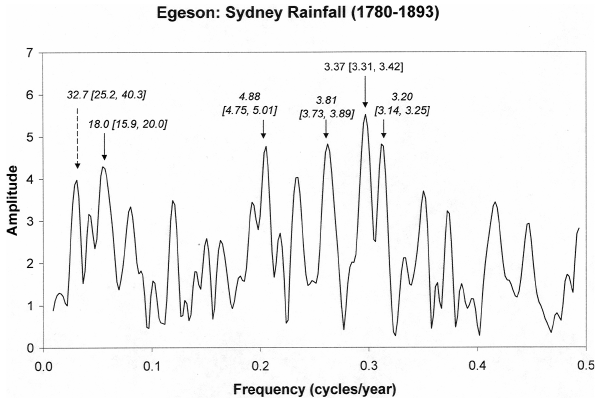
Figure 5. An extended linear-nonlinear cosinor spectrum of data taken o ff Egeson’s graph on rainfall, on top of Fig. 1b, validates his, Francis Bacon’s and others’ intuitions. Egeson, however, did take the time to compile data in support of their proposition. This ex- tended cosinor analysis shows the great uncertainties involved, by ordering 95% confidence intervals of the periods. The 95% confi- dence interval of the 32.7-year estimate extends from 25.2 to 40.3 years with Marquardt’s conservative method 4 . The confidence in- tervals are dubbed “ordering” since the assumption upon which they are based may not apply. They are o ff ered in the want of more per- tinent procedures that account for nonstationarities. ©